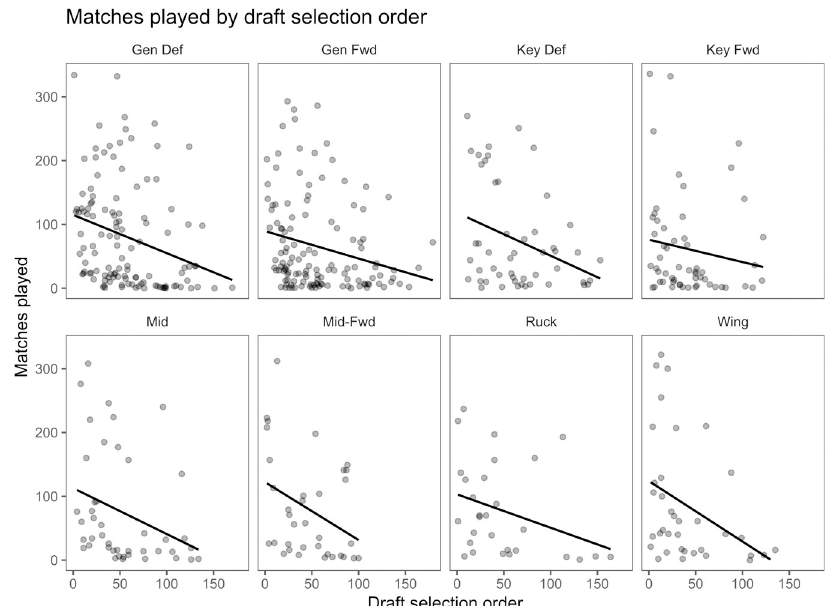
Fig 5. Relationship between draft selection order and matches played relative to playing position.